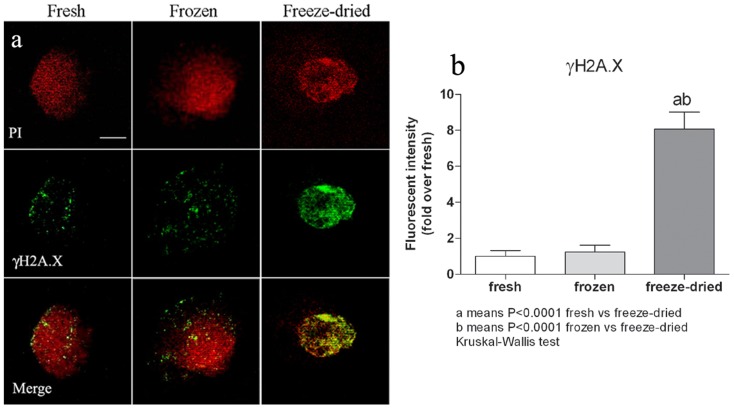
Induction of γH2AX in pronuclei of oocytes injected with nuclei, either from fresh, frozen or freeze-dried lymphocytes.(a) PI = pronuclei stained with propidium iodide; γH2AX = phosphorylated H2AX, a marker of DSBs and, indirectly, of DNA repair; Merge = PI+γH2AX. (b) The γH2AX fluorescent intensity was higher in pronuclei of SCNT-derived embryos using nuclei from freeze-dried cells than in pronuclei of embryos obtained using nuclei from frozen (p<0.0001) or fresh cells (p<0.0001); (Kruskal-Wallis test). Data represent the mean ± SEM of 10 embryos for each group. Scale bar = 10 µm.